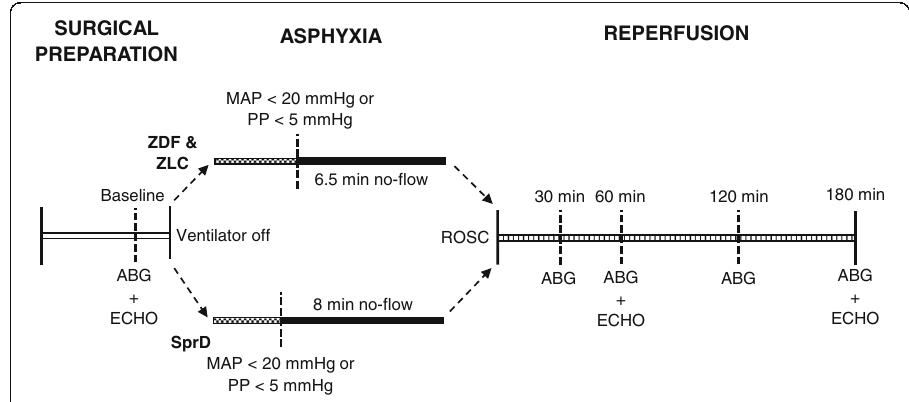
Fig. 1 Study design. Surgical preparation and monitoring during reperfusion were similar between all the three groups. During asphyxia, ZDF and ZLC groups underwent 6.5 min no-flow (top tier) and the SprD group underwent 8 min no-flow (lower tier), to ensure similar total asphyxia time. MAP: mean arterial pressure, PP: pulse pressure, ROSC: return of spontaneous circulation, ABG: arterial blood gas, ECHO: echocardiography, ZDF: Zucker diabetic fatty group, ZLC: Zucker lean control group, SprD: Sprague Dawley